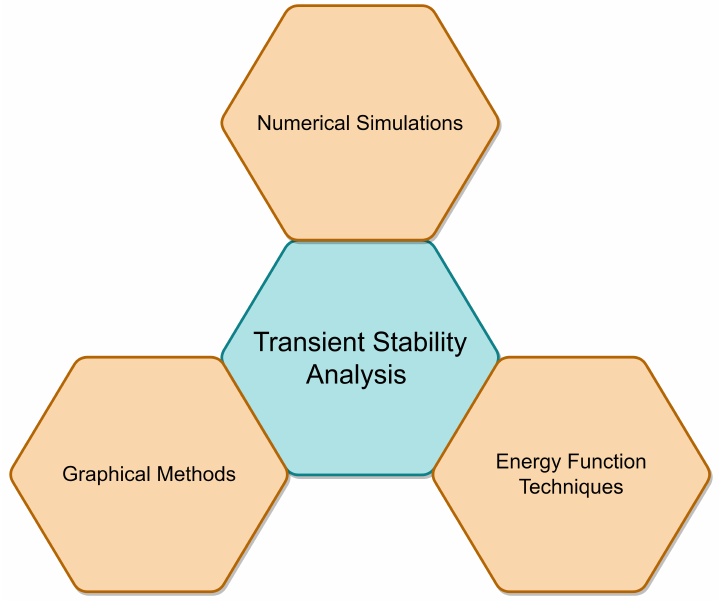
Figure 8. Transient stability analysis